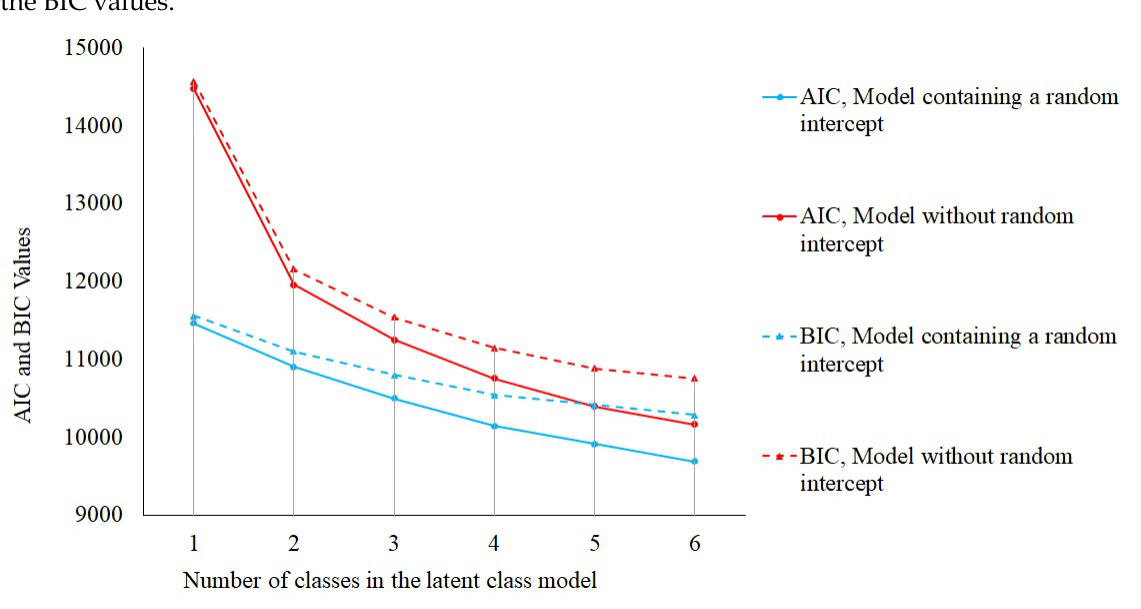
Figure 4. AIC and BIC values of the latent class